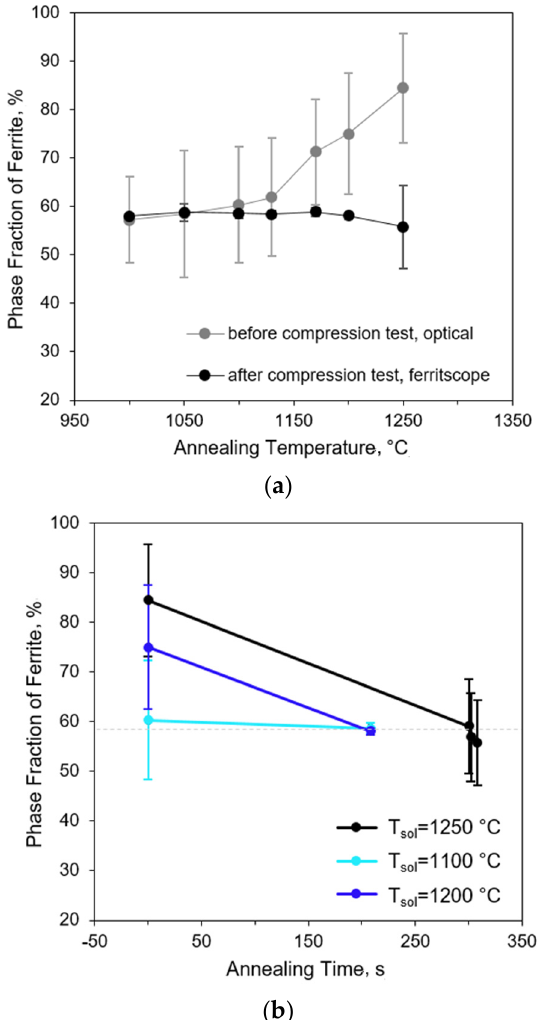
Figure 4. ( a ) Initial and final ferrite fraction measured by the line section method or ferritscope for the different solution annealing temperatures T sol . ( b ) Initial and final ferrite fraction for material condition of 60% (1100 °C) and 75% (1200 °C) and evolution of ferrite fraction during pre-heating, as well as during the compression test of 84% (1250 °C).